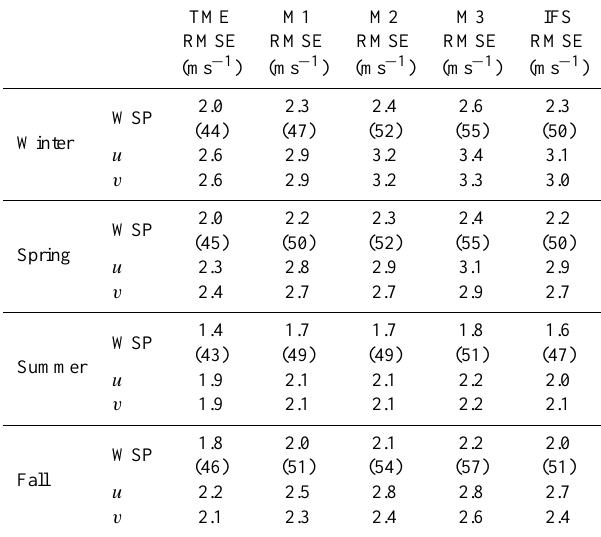
Table 3. Same as Table 2 but for the unbiased models (RMSE only). Values in parentheses show the error in percentage of the seasonally averaged wind